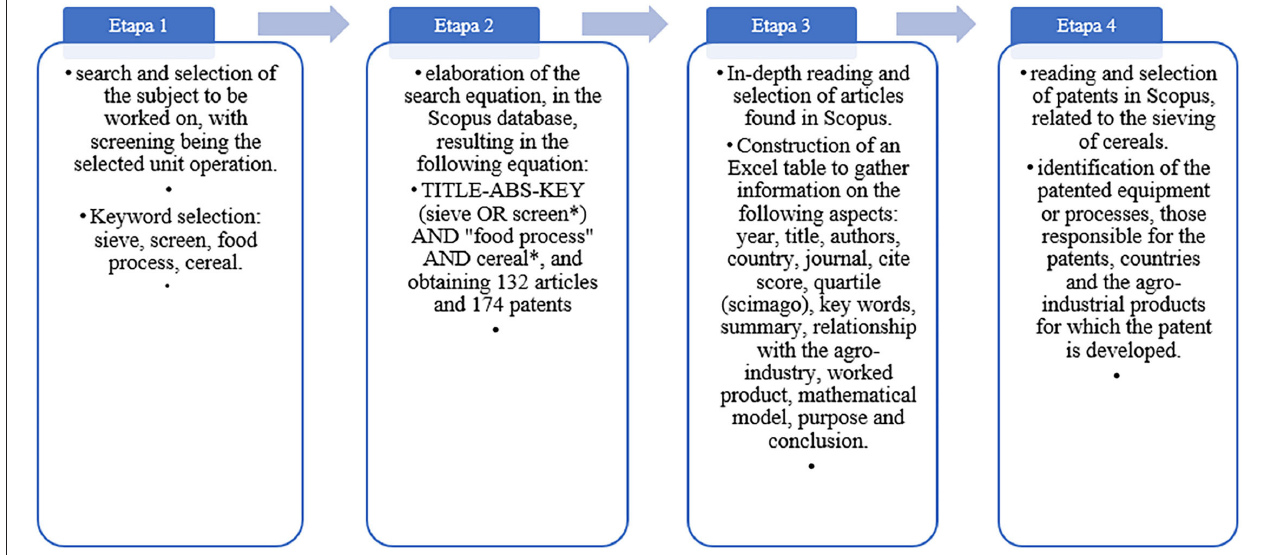
Frontiers in Sustainable Food Systems |